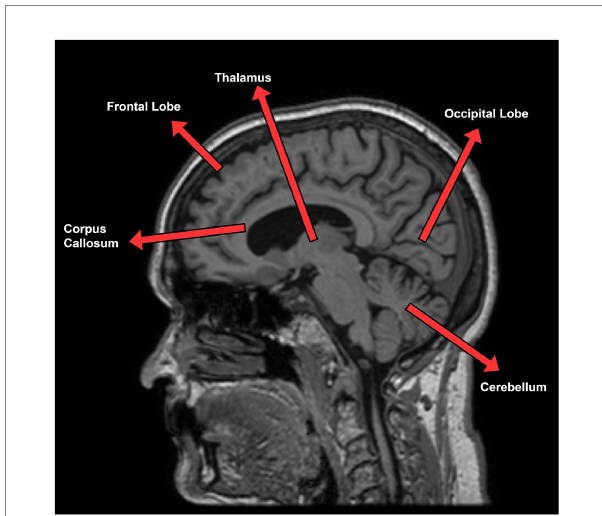
FIGURE 1 Sagittal plane view of MRI scan taken from ADNI dataset describing AD relevant section of the